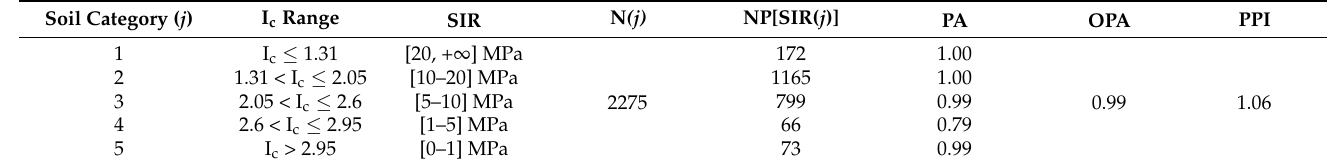
Table 6. Summary of Soil Improvement Range for Soil categories.